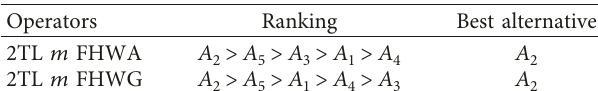
Table 4: Score values for all the 2TL3F numbers 􏽢 p